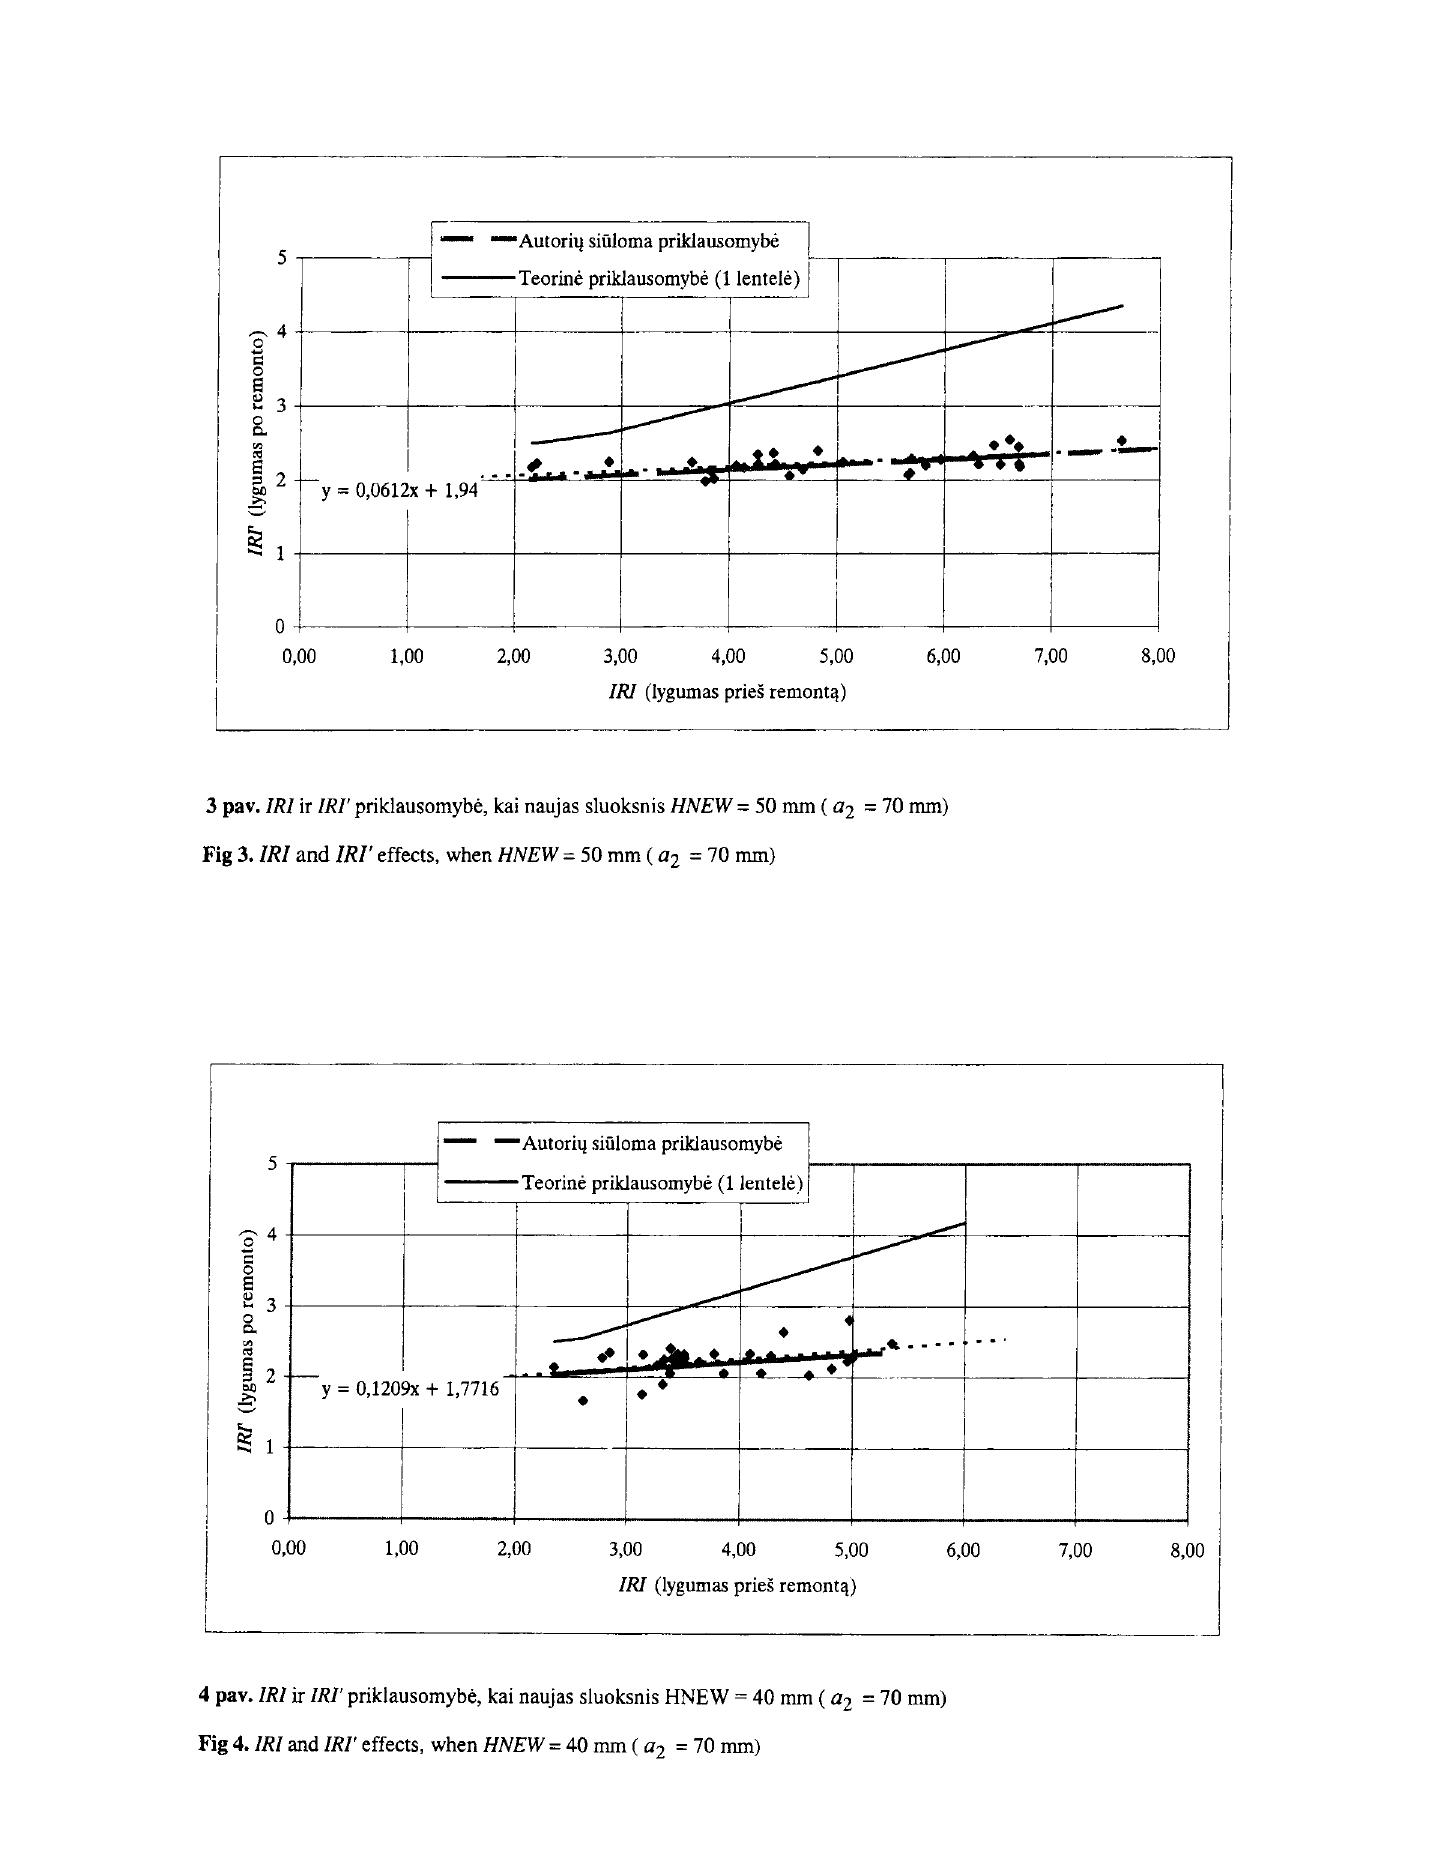
Fig 4. IR! and IRI' effects, when HNEW = 40 mm ( a 2 = 70